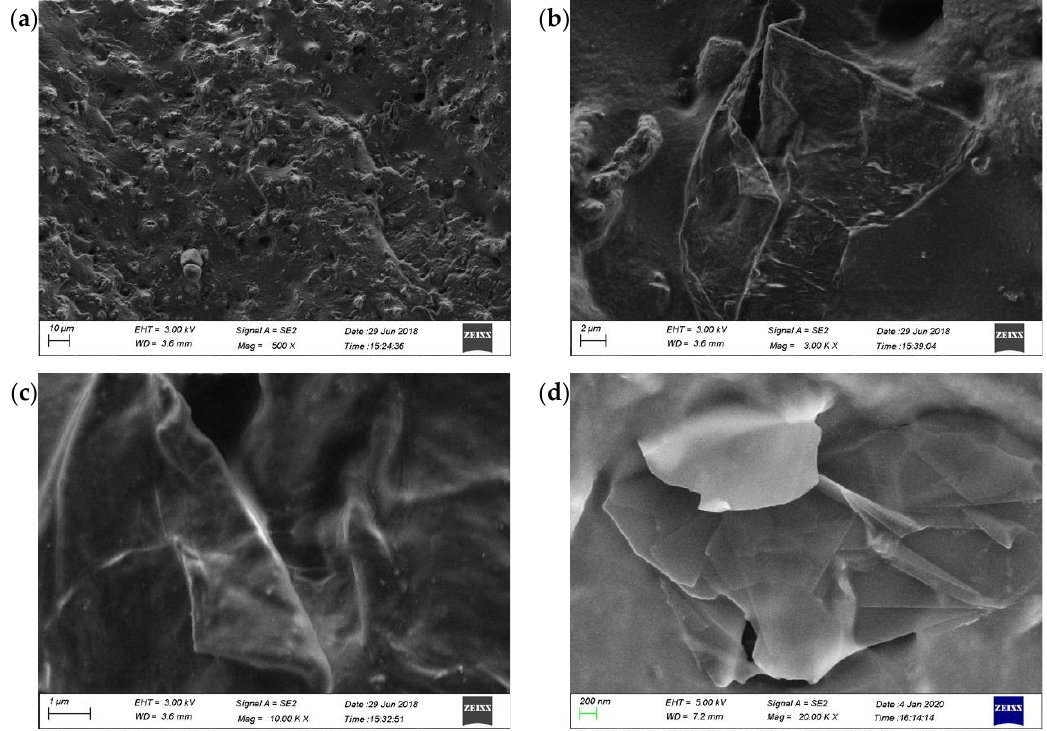
Figure 7. SEM images of SR/vinyl-GO nanocomposites with varied vinyl-GO contents. ( a – c ), 8 parts of vinyl-GO content. ( d ), 10 parts of vinyl-GO content.